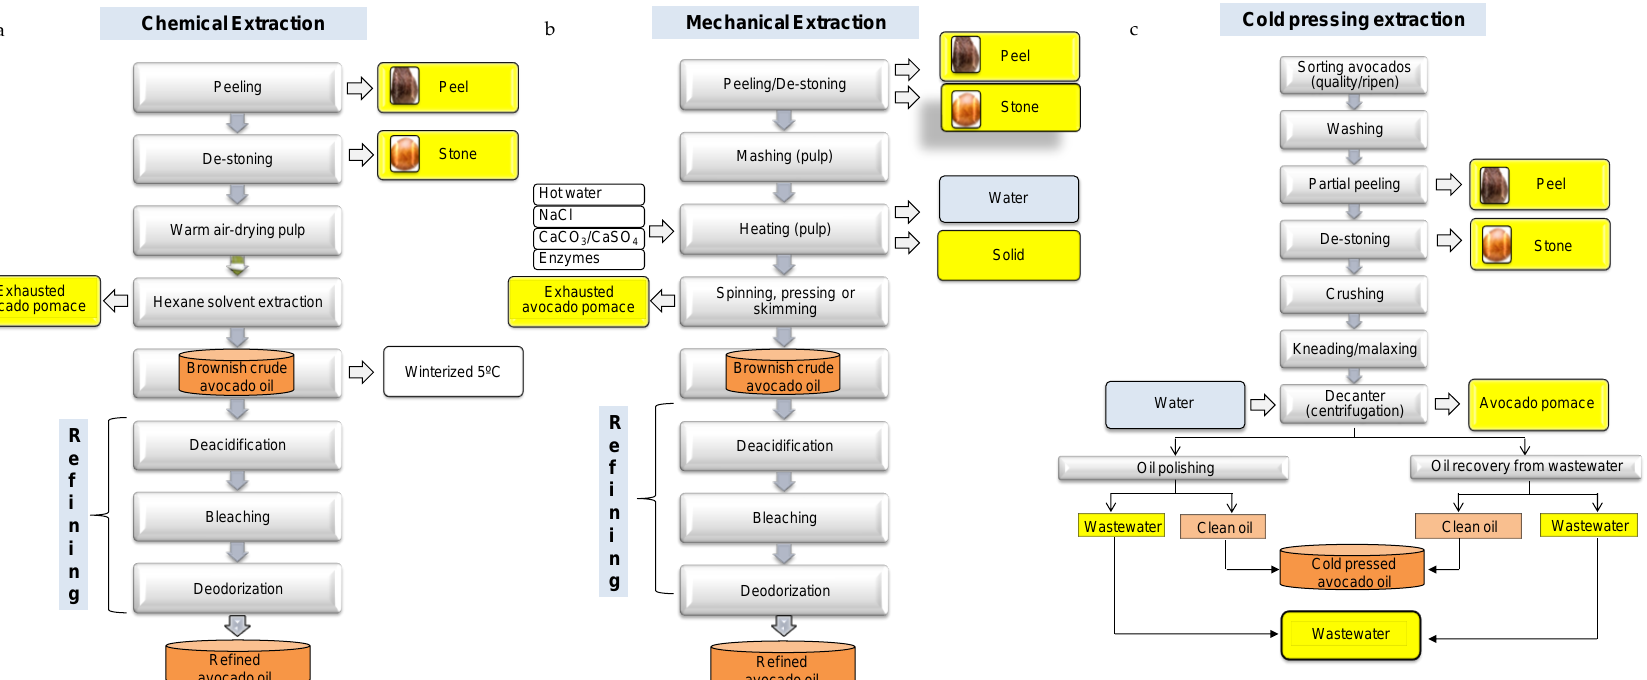
Figure 4. Chemical ( a ), mechanical ( b ), and cold-pressing extraction ( c ) of avocado oil and the by-products/waste obtained (yellow squares).